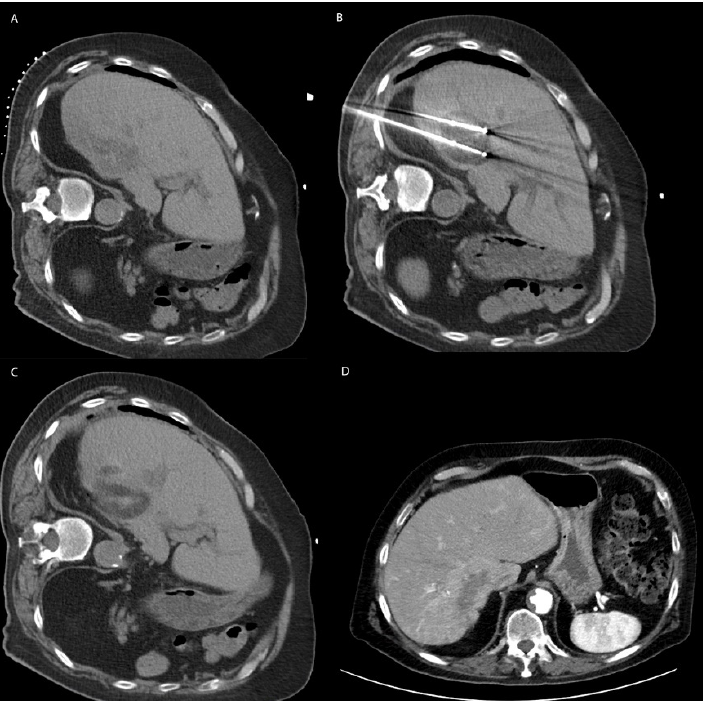
Figure 3. Representative image of Cryotherapy. ( A ) Noncontrast enhanced axial CT demonstrating a large hypoattenuating metastasis in liver segment 7 of an 83-year-old male with history of ascending colon cancer status post hemicolectomy. ( B ) Intraoperative noncontrast axial CT demonstrating ice ball formation around two percutaneous cryoablation probes within the metastasis. ( C ) Imme- diately following cryoablation, thermal damage is demonstrated by a region of hypoattenuation. ( D ) Two years later, the patient unfortunately presented with another large metastatic lesion within right liver lobe concerning for recurrence. Deemed unresectable by Surgery and too large for re- peat